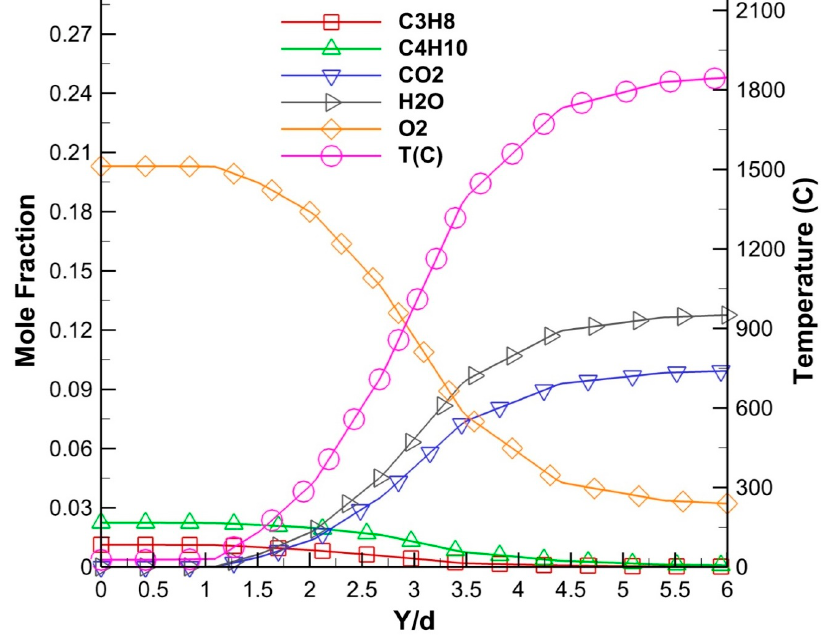
Figure 9. Species mole fraction and temperature variations of the stoichiometric LPG/air mixture with respect to the main jet flow direction (Y/d) for Re = 3483 by numerical simulation. respect to the main jet flow direction (Y/d) for Re = 3483 by numerical